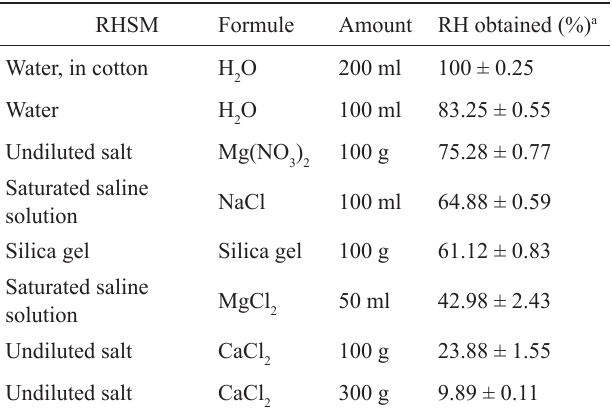
Table 1 . RHSM and amounts used to obtain different